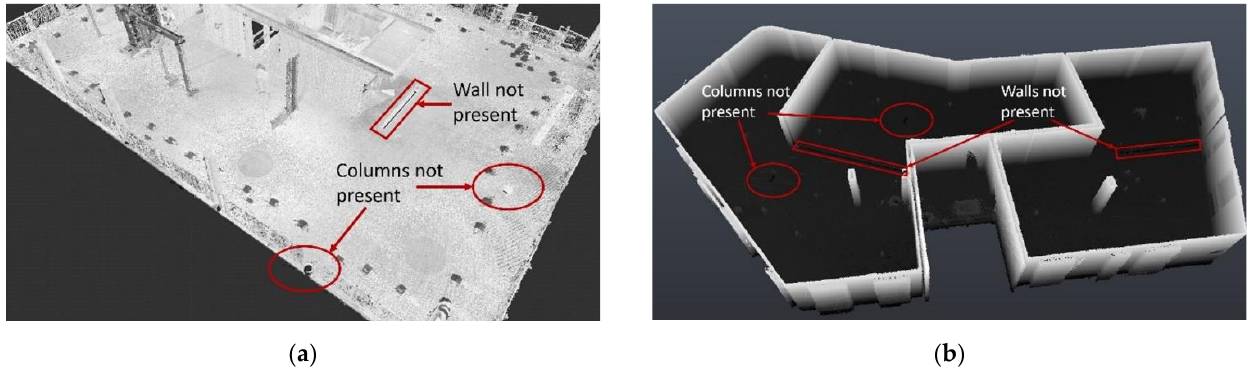
Figure 12. Method evaluation by removing objects in point cloud data: ( a ) a wall and two columns were removed in SQVERAS 3rd, and ( b ) two walls and two columns were removed in PILIAMIESTIS A1 point cloud models.